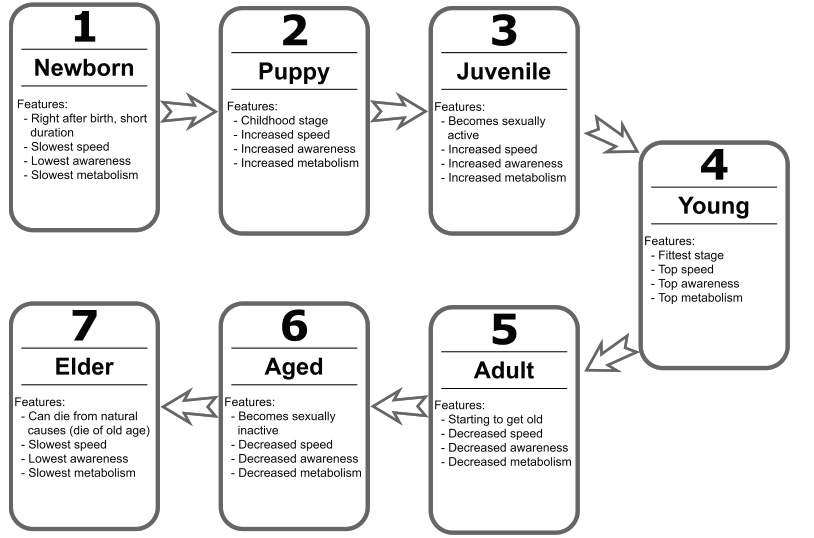
Figure 7. According to the aging mechanics, animals change over time. The animal’s attributes can be changed in each age stage. We provided a sample setup, where “Newborn” and “Elder” animals have the worst attributes, and “Juvenile” and “Aged” stages also change the sexually active status.